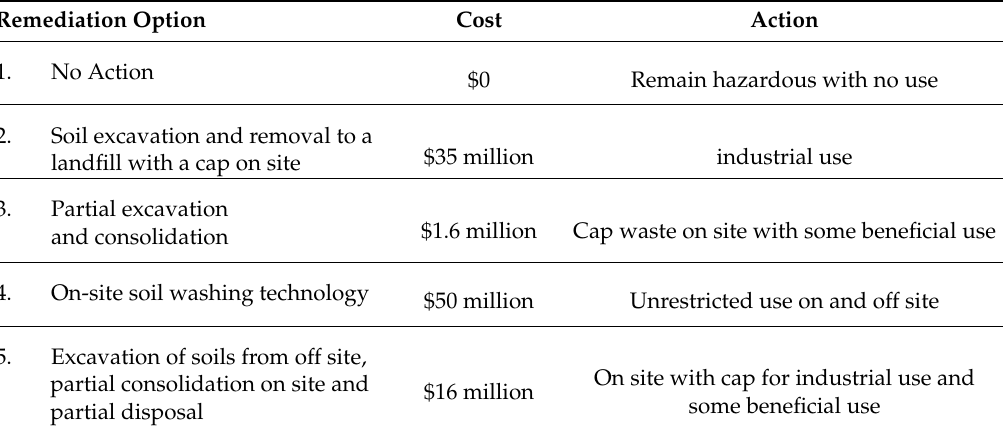
Table 1. DEC Remediation